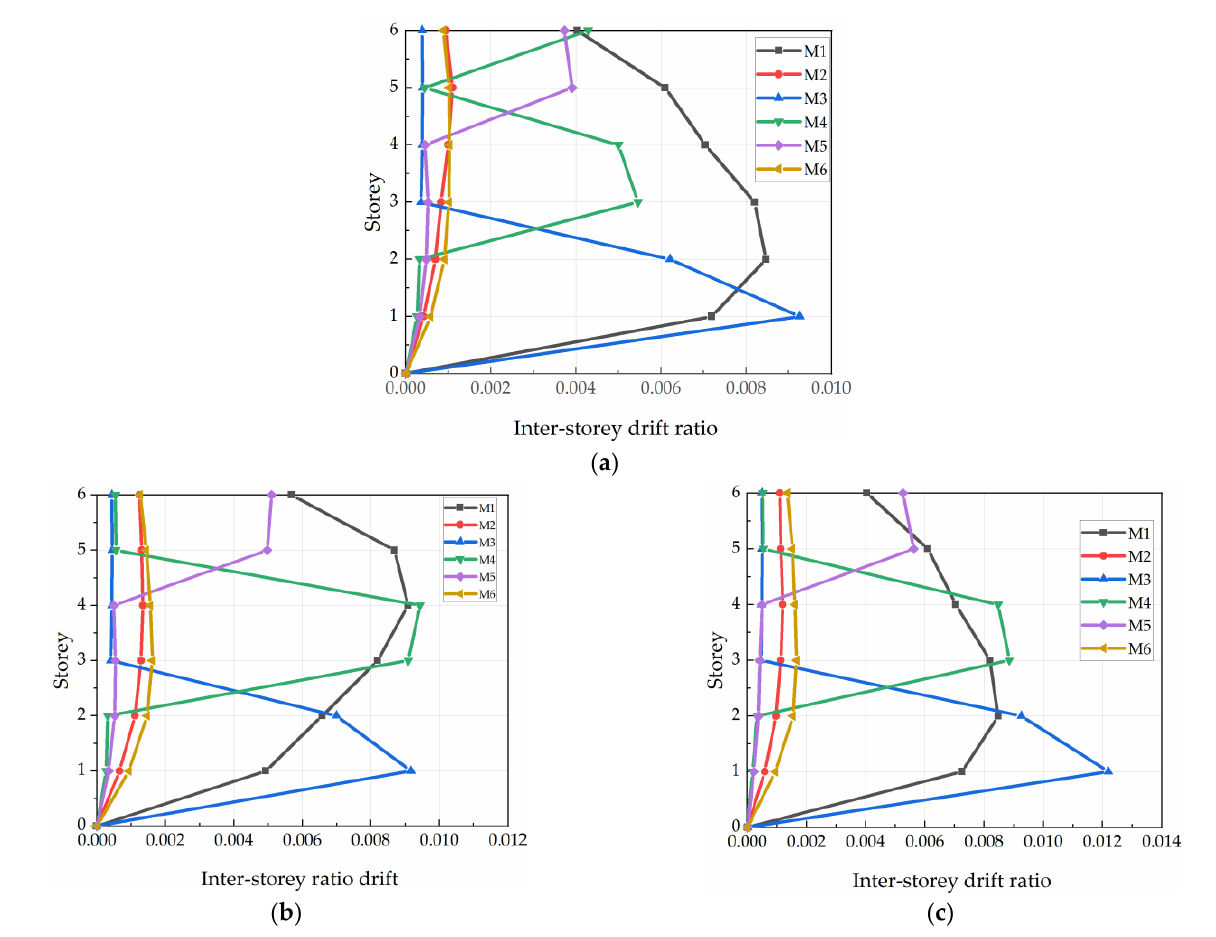
Figure 12. Interstorey drift ratio of six models under three ground motions: ( a ) for artificial ground motion; ( b ) for taft ground motion; ( c ) for Tang Shan ground motion.